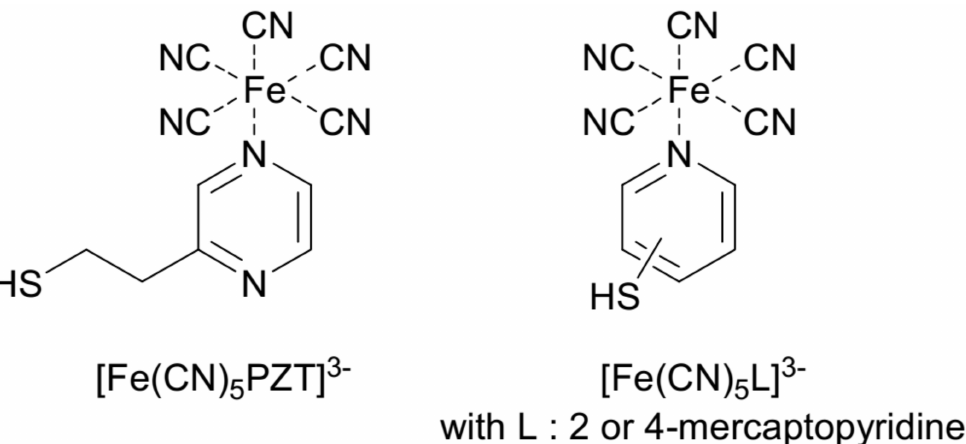
Figure 14. Prussian blue-modified complexes. Reproduced with permission from reference [122], ACS, 2007. Like 2-pyrazin-2-ylethanethiole [123] or 2 and 4-mercaptopyridine [124], the